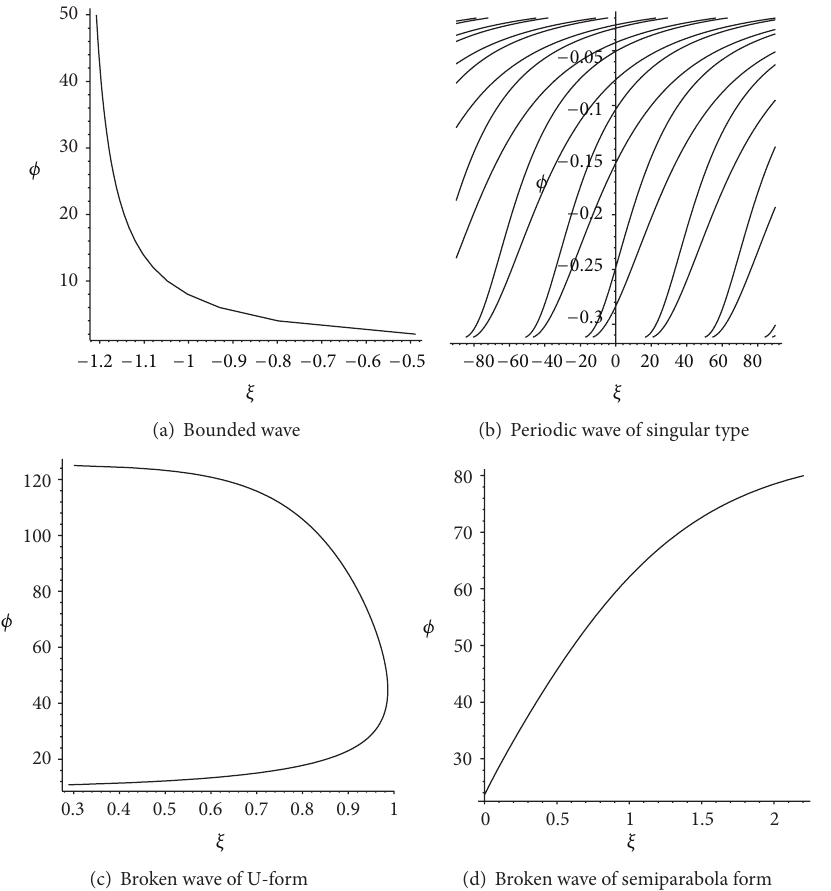
Figure 3: The profiles of solutions (81), (88), (96), and (97) for the fixed parameters.